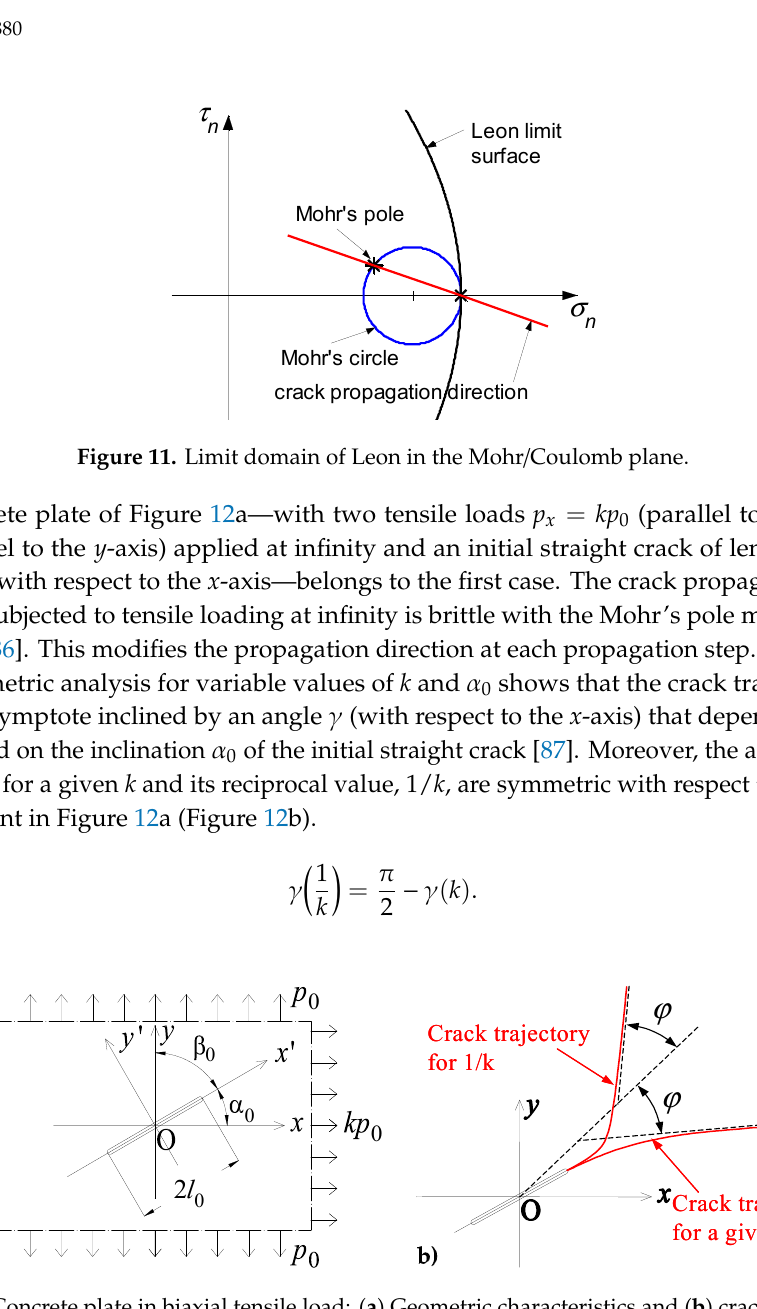
Figure 12. Concrete plate in biaxial tensile load: ( a ) Geometric characteristics and ( b ) crack trajectories for a given k and 1/ k .